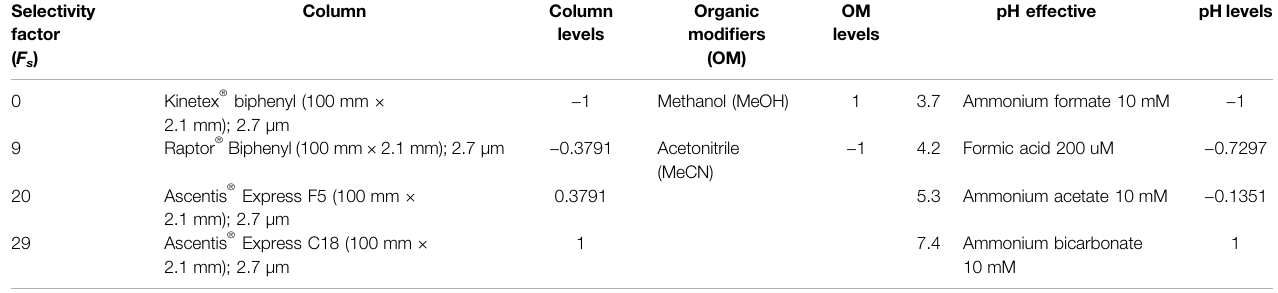
TABLE 1 | Critical method parameters (CMPs) and levels used in the development of the chromatographic conditions in Step 1.